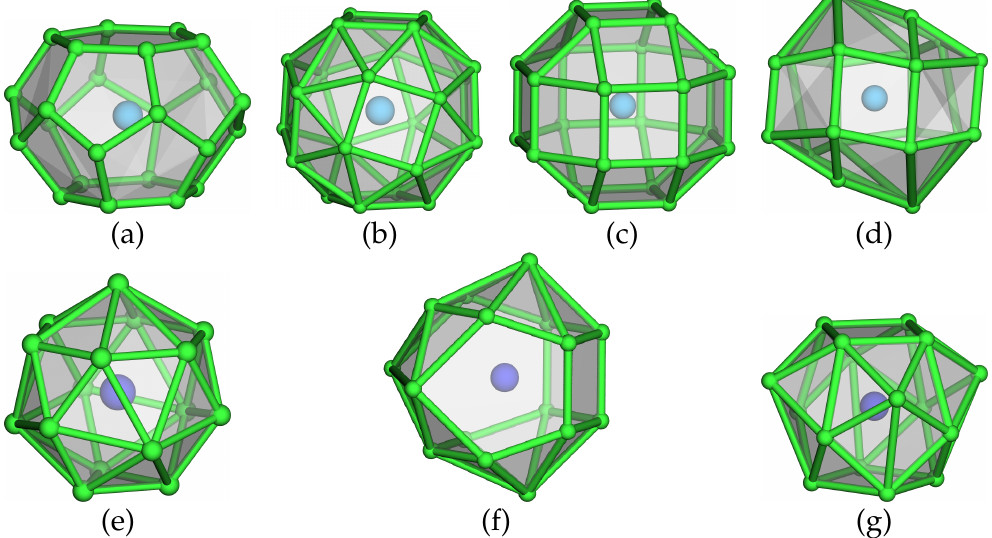
Figure 3. Upper row: polyhedra for coordination number 24: ( a ) truncated hexagonal trapezohedron occurring in clathrates of type I, ( b ) snub cube as found in the NaZn 13 structure type, ( c ) rhombicuboc- tahedron in CsNa 2 Hg 18 , ( d ) intermediate step between ( b , c ) as observed in the crystal structure of CsIn 12 . Lower row: polyhedra for coordination number 16: ( e ) Frank–Kasper-type polyhedron (fourcapped truncated tetrahedron) as found in MgCu 2 -type structures, ( f ) fourcapped hexagonal prism, realised in many AlB 2 -type structures, ( g ) snub square antiprism in CsNa 2 Hg 18